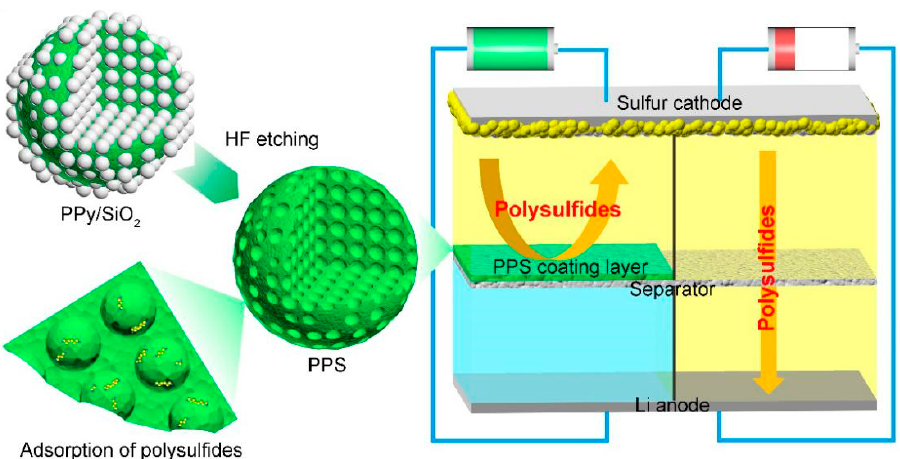
Figure 1. Schematic of PPS structural characteristics and Li-S cell with PPS-modified separator.